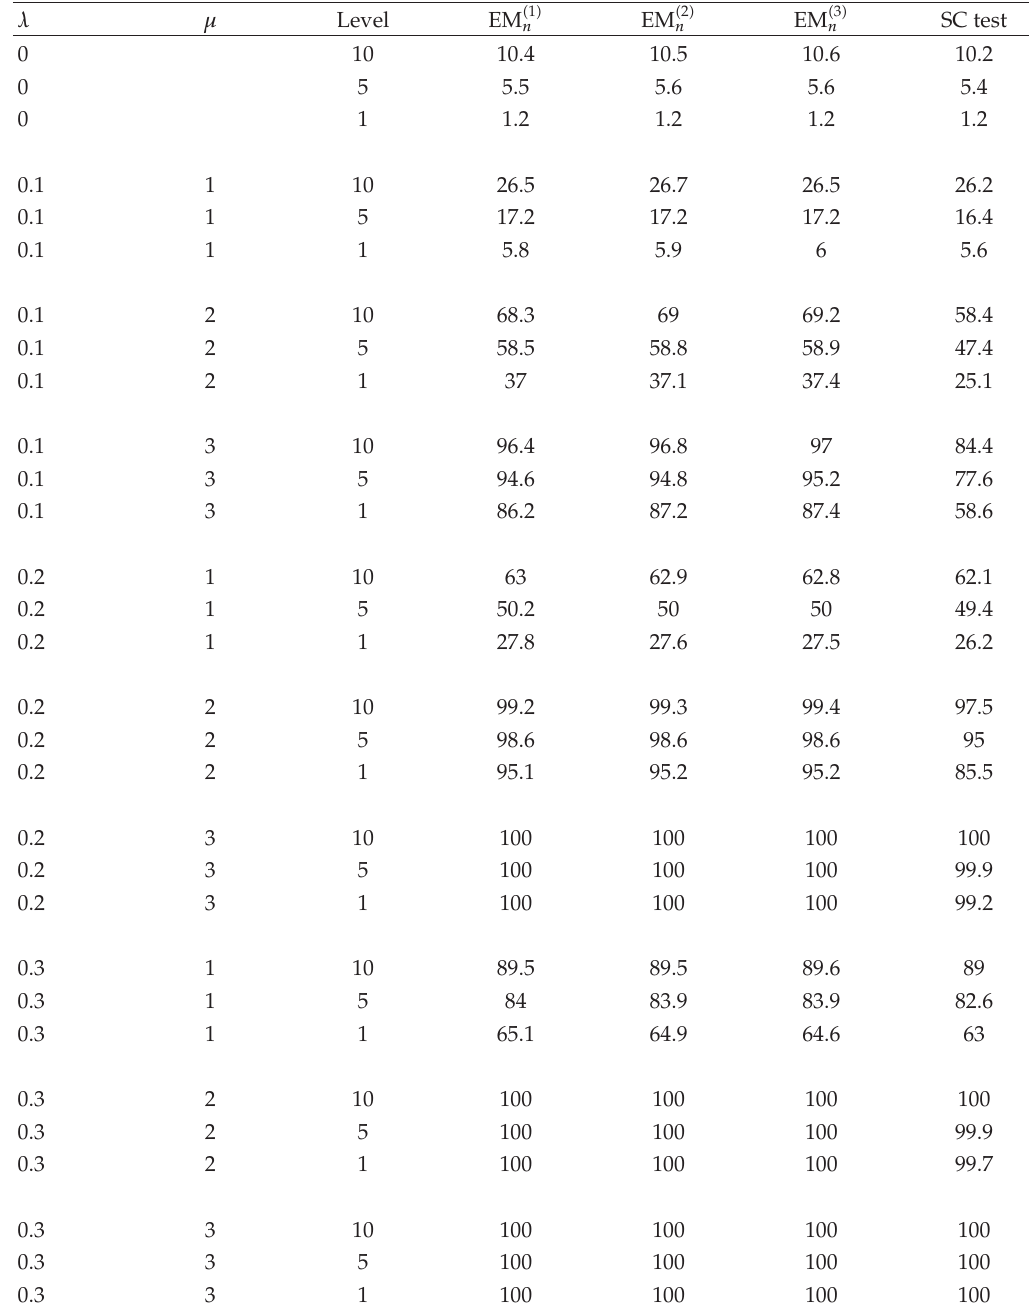
Table 2: Type I error and power comparisons (cid:2) % (cid:3) of the EM test and the score test (cid:2) SC test (cid:3) for log-normal model: n 0 (cid:5) n 1 (cid:5)